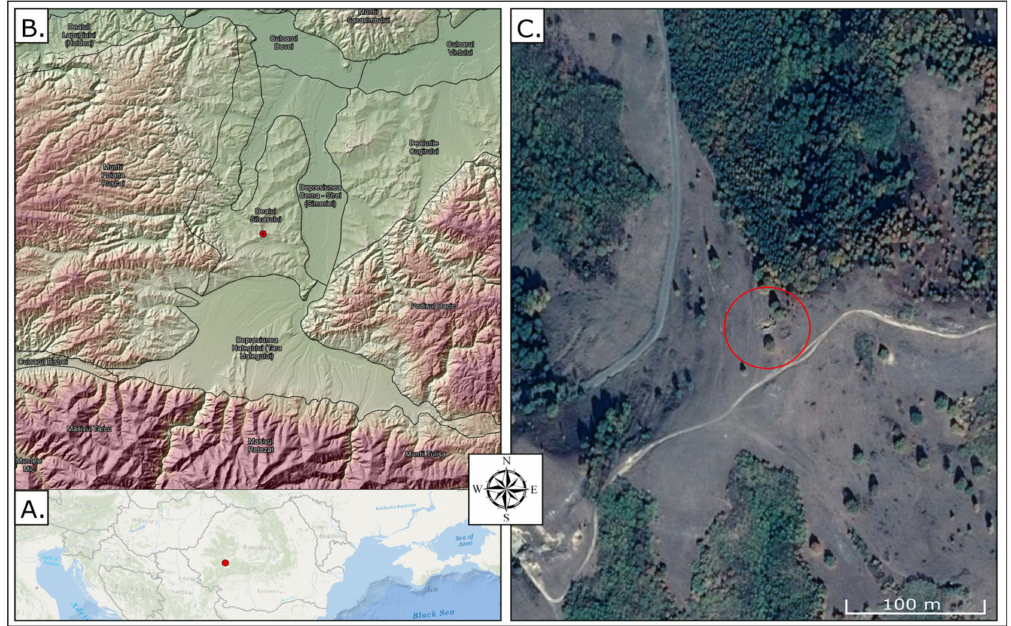
apului ( A , B ); Google Earth image of the site ( C ). The archaeological excavation u de Jos— Dealu T , ,